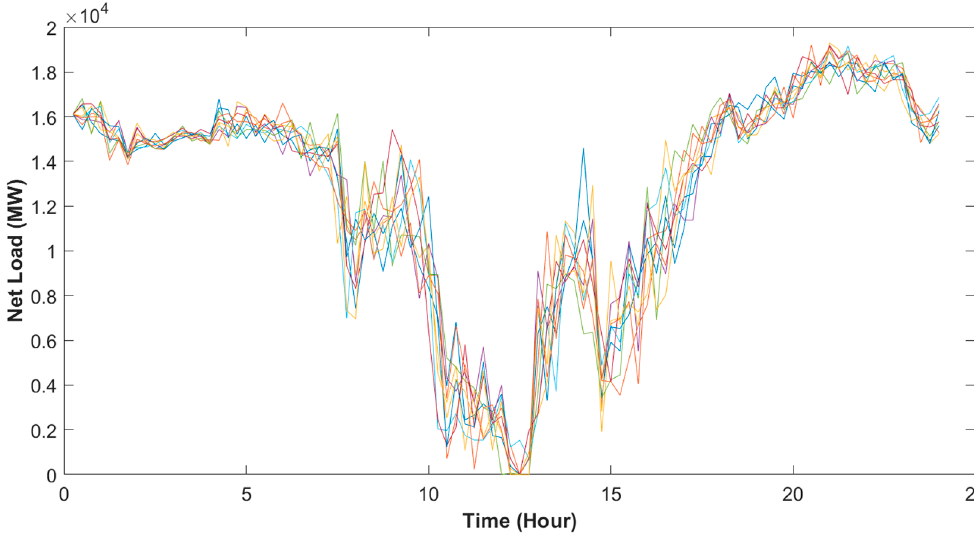
Figure 6. Renewable-energy variation “medium” in 10 sets of net-load scenarios in spring.